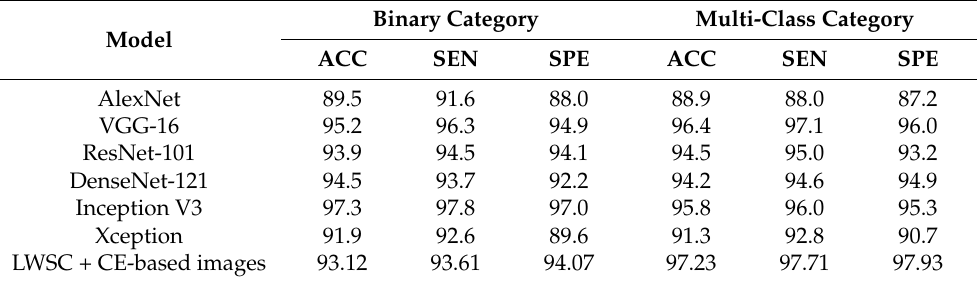
Table 5. Fair comparison of the proposed model on BreakHis dataset using different pre-trained models on the same computing